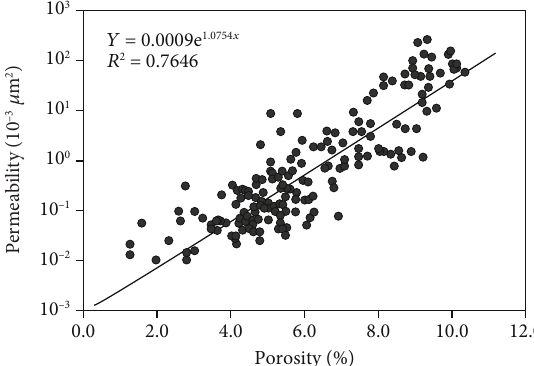
Figure 3: Relationship between porosity and permeability of Shan-2 Member of the Shanxi Formation in the research area.